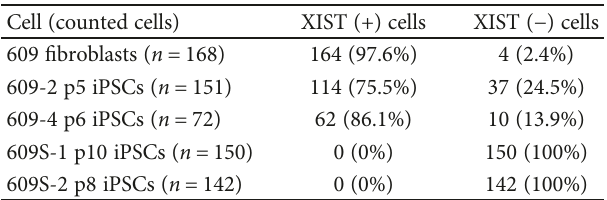
Table 1: XIST signals on the X chromosomes in the nuclei of fi broblasts isolated from a DMD-manifesting carrier (609) and four hiPS cells induced from 609 fi broblasts (609-2, 609-4, 609S-1, and